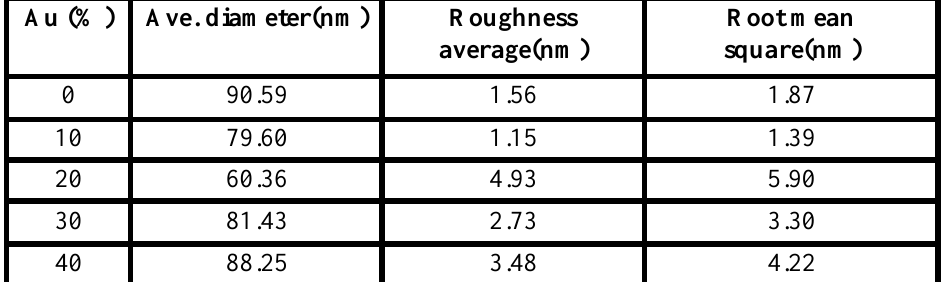
and doping with different ratio of Au thin 3 films.